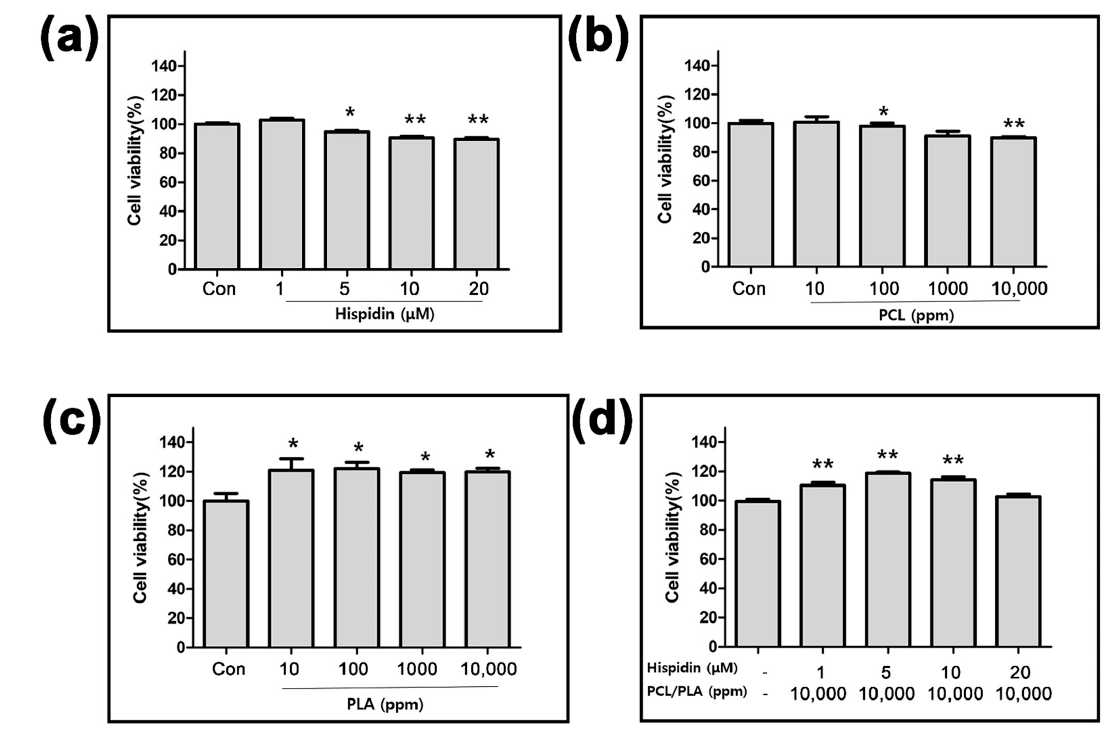
Figure 3. Cell viability test with hispidin, PCL, PLA, and their mixture in B16F10 melanoma cells. ( a ) B16F10 cells were treated with various concentrations (1–20 µM) of hispidin, ( b ) PCL (10–10,000 ppm), and ( c ) PLA (10–10,000 ppm) for 24 h. Cell survival was measured by 3-(4,5-dimethylthiazol-2-yl)-2,5-diphenyltetrazolium bromide (MTT) assay. ( d ) B16F10 cells were pretreated with hispidin (1–20 µM) mixed with PCL/PLA at identical concentrations (10,000 ppm). * p < 0.05, ** p < 0.01 versus control.